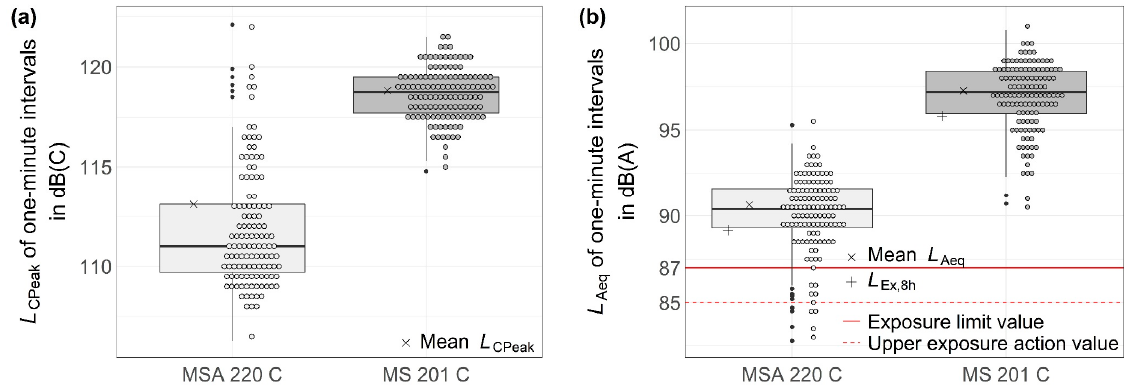
Figure 4. ( a ) 𝐿 (cid:2887)(cid:2900)(cid:2915)(cid:2911)(cid:2921) values ( b ) 𝐿 (cid:2885)(cid:2915)(cid:2927) values of the one-minute measuring intervals. Figure 4. ( a ) L CPeak values ( b ) L Aeq values of the one-minute measuring